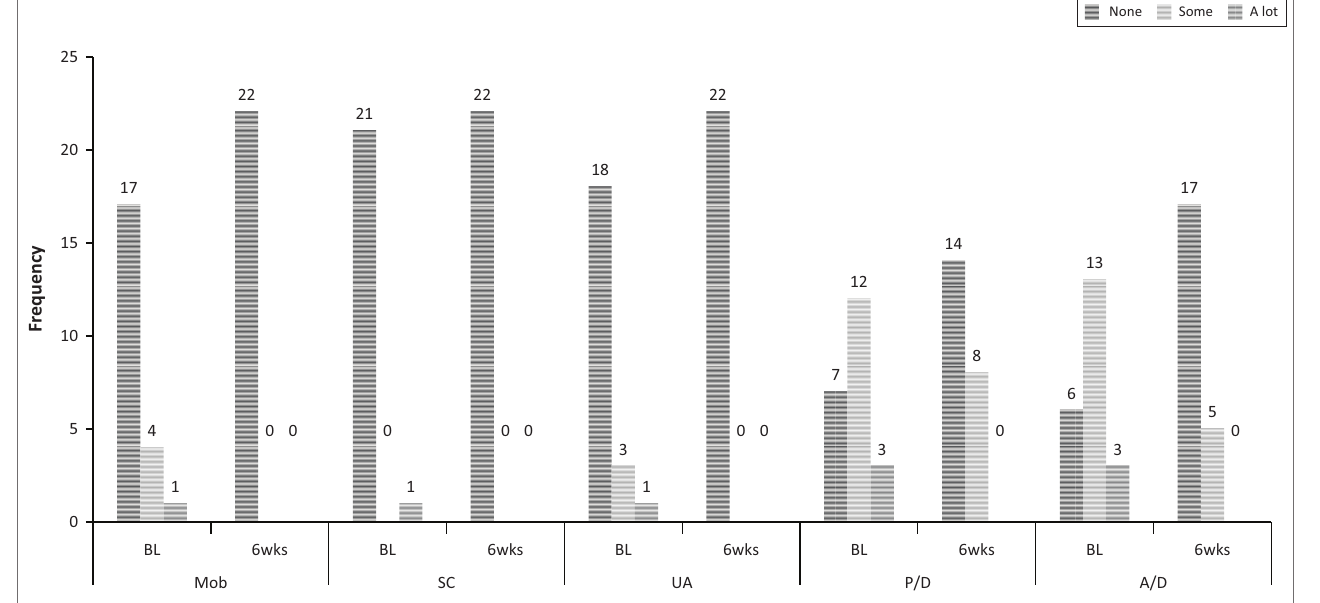
FIGURE 2: Baseline and 6 weeks frequency of responses to the five dimensions of the EQ-5D-3L for the experimental group.